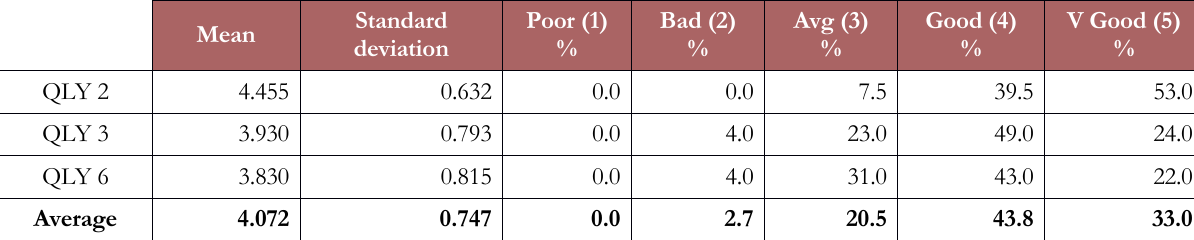
Table 7. Quality factor responses